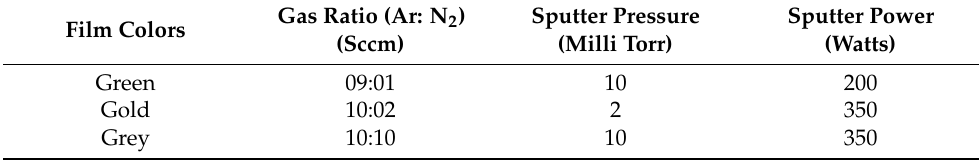
Table 3. Sputtering parameters for Titanium Nitride different colored thin film deposition.